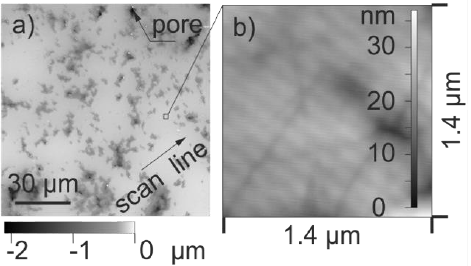
Figure A1. Surface topography of a polished LTCC ceramic substrate, captured by ( a ) laser scanning microscopy (LSM); ( b ) atomic force microscopy (AFM) beside pores.